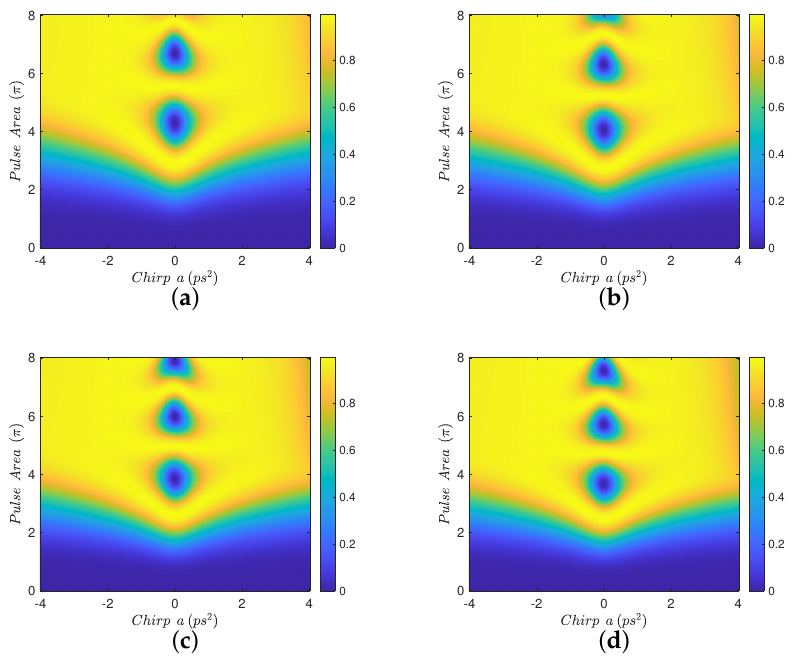
Figure 8. Contour diagrams for the biexciton population at the final time, as function of the pulse area and the chirp parameter a of the applied Gaussian pulse, with biexciton energy shift E b = − 15 meV, initial Gaussian pulse duration τ 0 = 0.75 ps, a constant distance d = 4 nm between the quantum dot and the surface of the nanoparticle, and four different nanoparticle radii: ( a ) r mnp = 7 nm, ( b ) r mnp = 8 nm, ( c ) r mnp = 9 nm, and ( d ) r mnp = 10 nm.